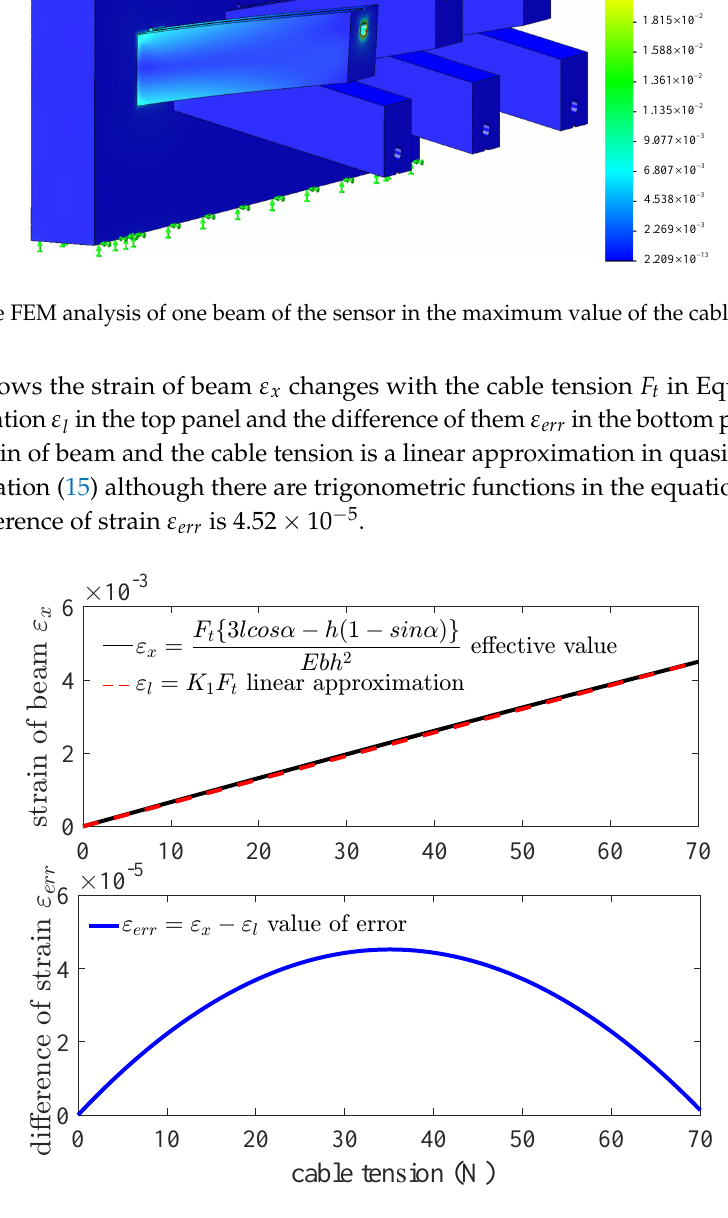
Figure 8. The strain of beam ε x changes with the cable tension F t in Equation (14) with a linear approximation ε l in the top panel and the difference of them ε err in the bottom